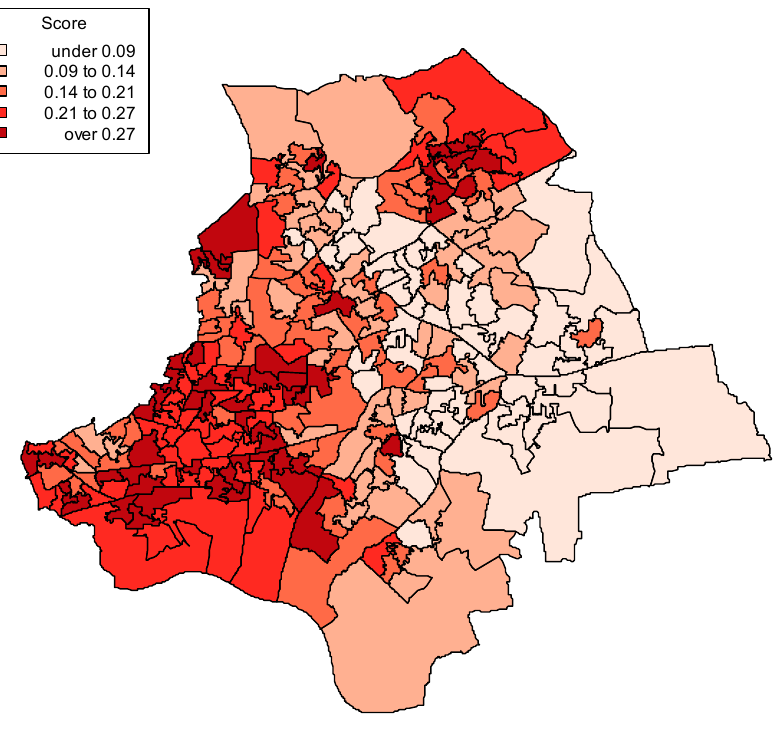
Figure 5. LSOA income deprivation scores.